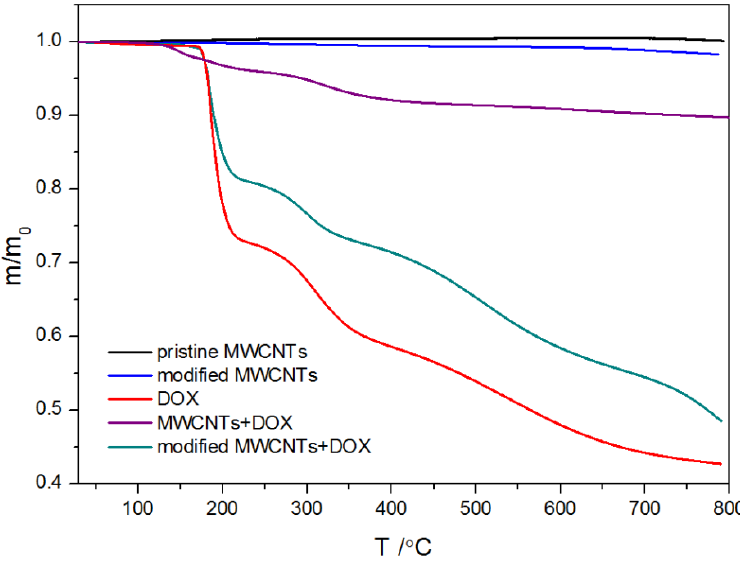
Figure 2. TGA curves determined under non-oxidizing atmosphere.